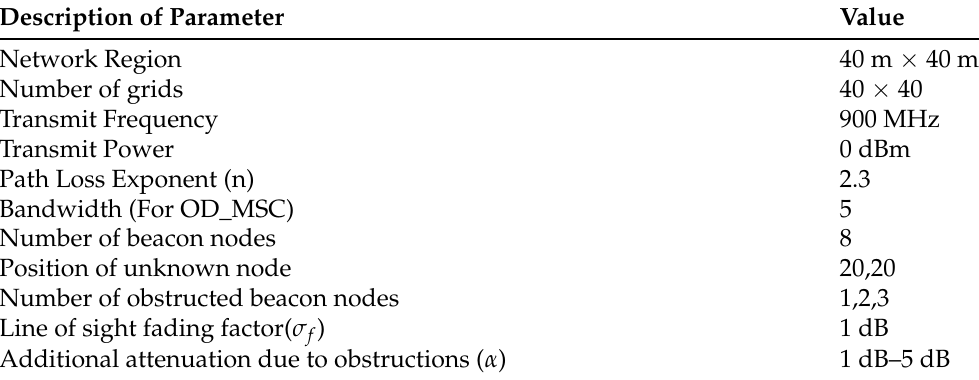
Table 1. Simulation